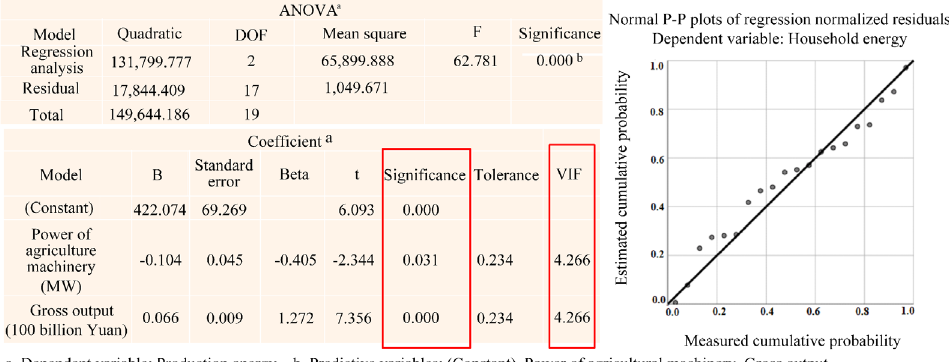
Figure 5. Multiple linear stepwise regression analysis of rural energy use in Guangdong.